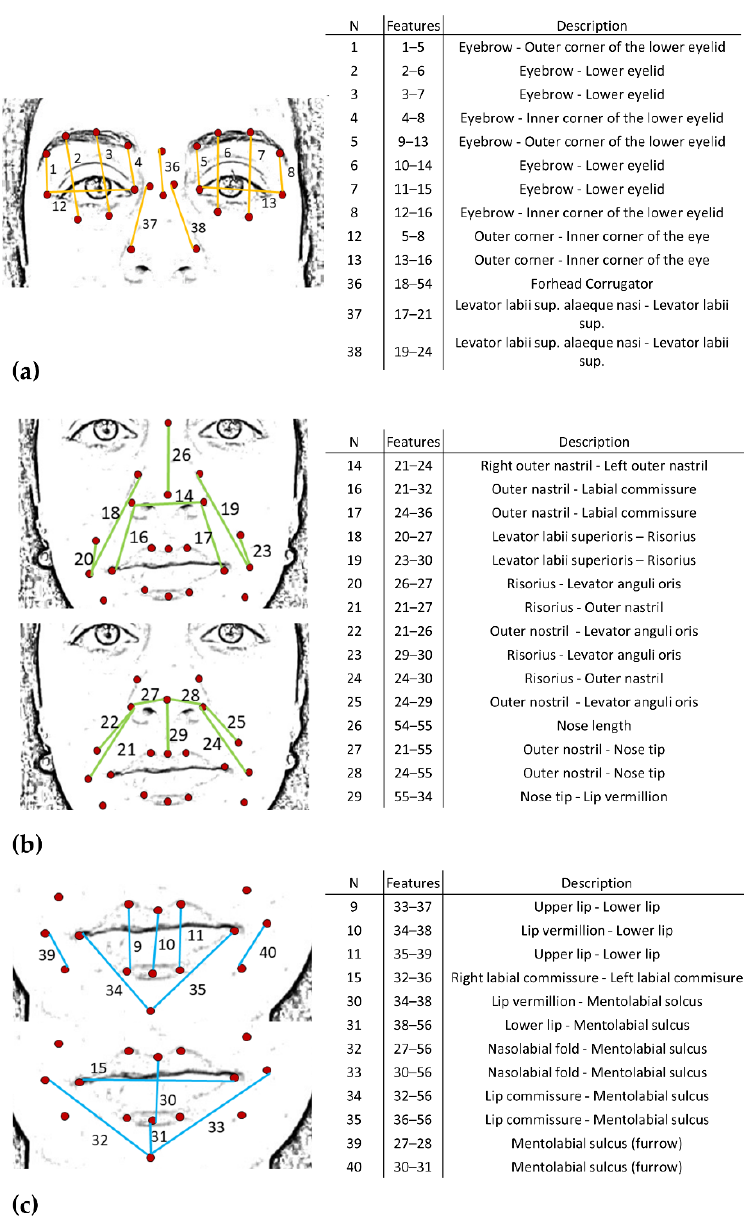
Figure 3. Description of the face distances. N = number of distances. Features = Pairs of features where the corresponding distance is calculated. Description = muscles related to the specific distance. ( a ) Upper face; ( b ) middle face; ( c ) lower face.